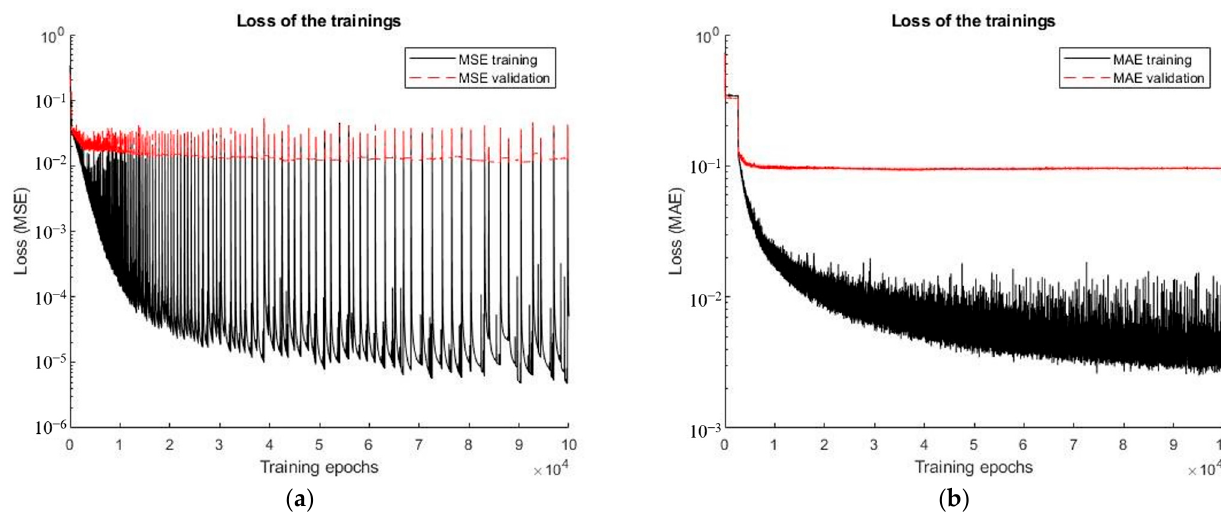
Figure 12. ( a ) Verification training epoch obtained when using the MSE. ( b ) Verification training epoch obtained when using the MAE. epoch obtained when using the